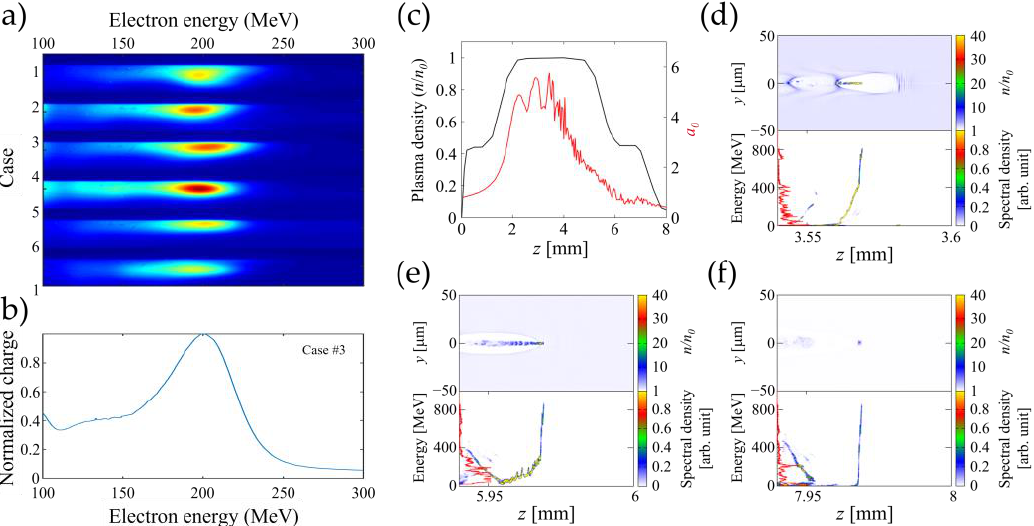
Figure 5. ( a ) False color images of the accelerated electrons on the LANEX 2 and ( b ) normalized charge as a function of electron energy. ( c ) The plasma profile was set similarly to the CFD simulation result. The PIC simulation results at three different positions are represented in ( d – f ). The red lines in left of the bottom panels are the spectral density in terms of beam energy.